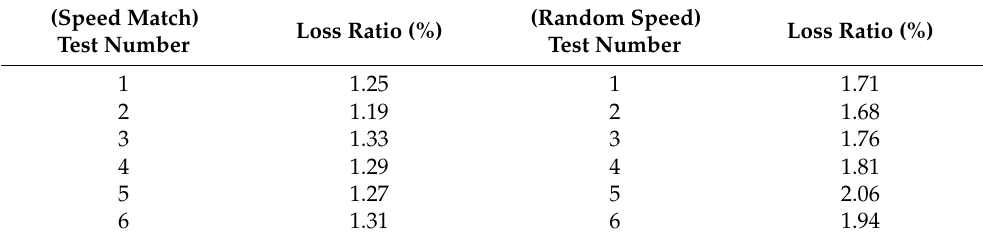
Table 8. The loss-rate table under speed-matching of rape and the loss-rate table under speed and forward speed of random rotation wheel.